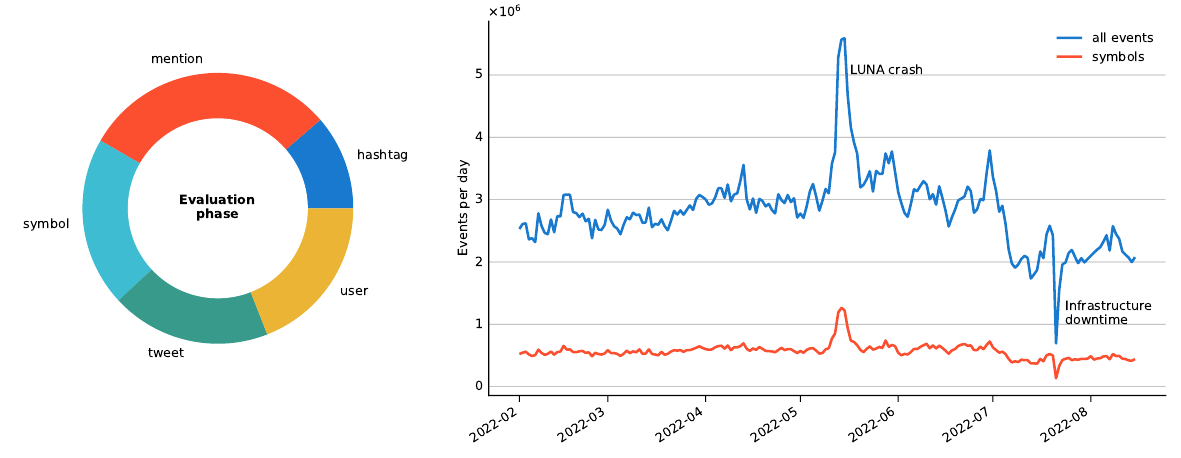
Figure 8. Recorded events (long-term evaluation phase of use case